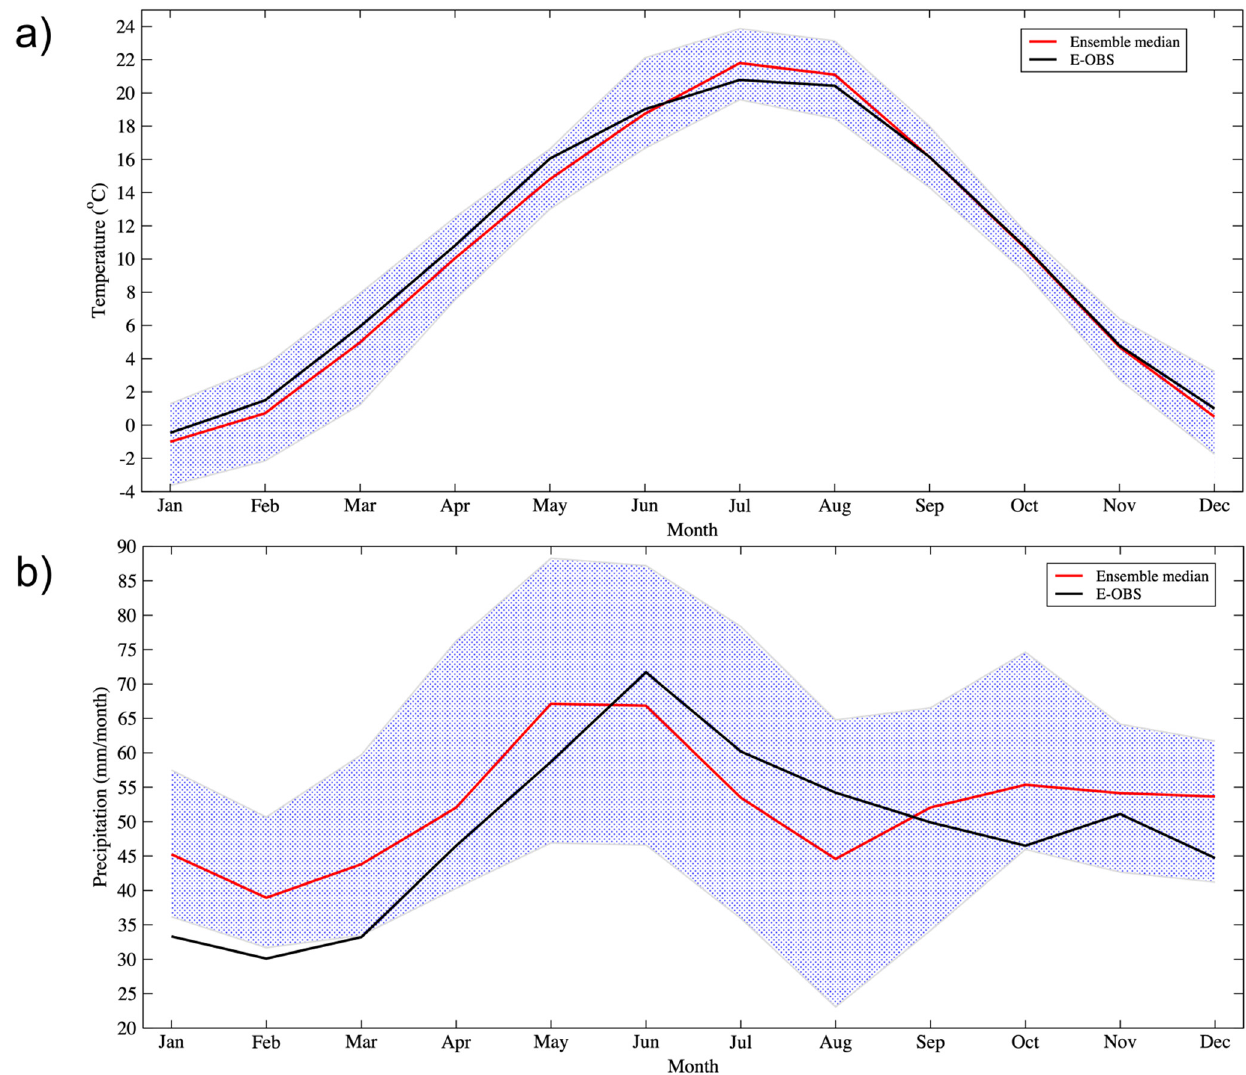
Figure 2. Monthly mean ( a ) temperature and ( b ) precipitation averaged over the Pannonian Basin for 1971–2000. The black line depicts the E-OBS dataset, the red line depicts the median of the RCM ensemble distribution, and the violet shaded region denotes the area between the 5th percentile and 95th percentile of the RCM distribution.